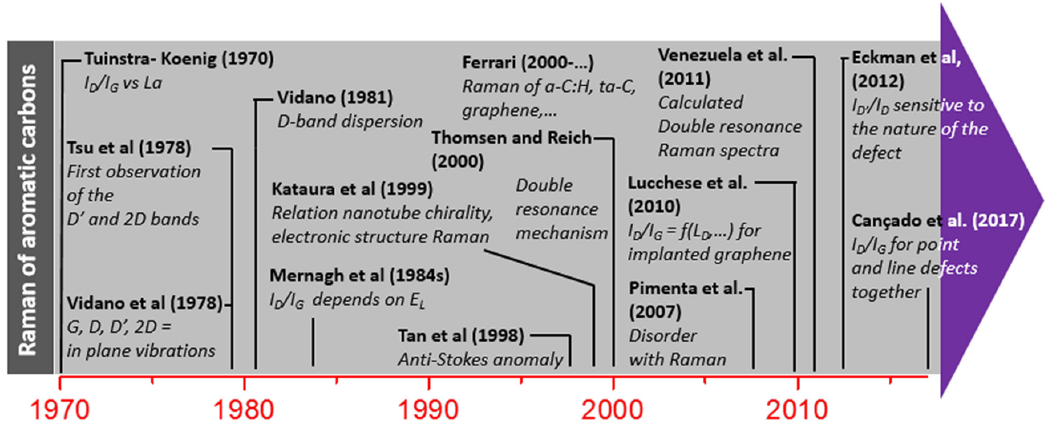
Figure 8. Chronology of the Raman effect applied to aromatic carbon.